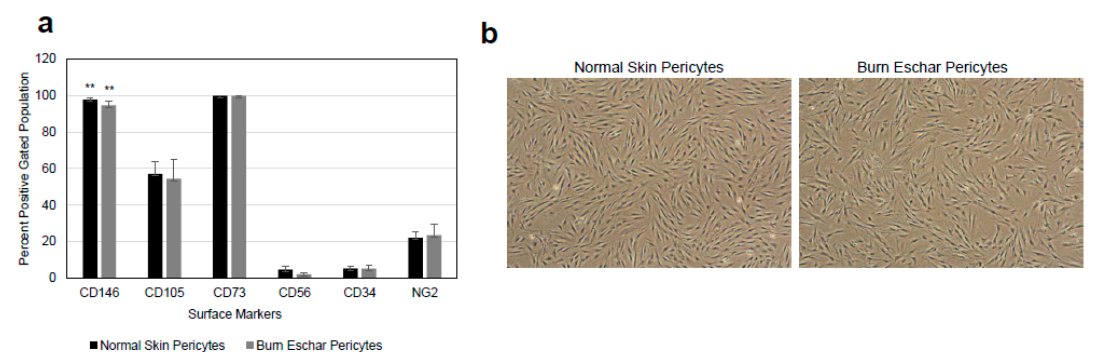
Figure 1. ( a ) Isolation and characterization of pericytes from skin. Cells grown in pericyte growth media were analyzed for the pericytes marker CD146 and neuron-glial 2 (NG2) and stem cell markers CD105 and CD73. The cells were also stained for the endothelial marker CD34 and skeletal muscle marker CD56. These cells did not express the endothelial marker CD34 or smooth muscle marker CD56 indicating that the isolated cell population are of pericyte lineage. Pericytes isolated from each of six different patients undergoing debridement after burn injury and breast reduction surgeries were used for flow analysis. Statistical analyses were performed using one-way analysis of variance (ANOVA) and p < 0.05 was considered statistically significant. ** p < 0.01. ( b ) Shown are representative phase-contrast images of pericytes isolated from normal skin and burn eschar tissues.